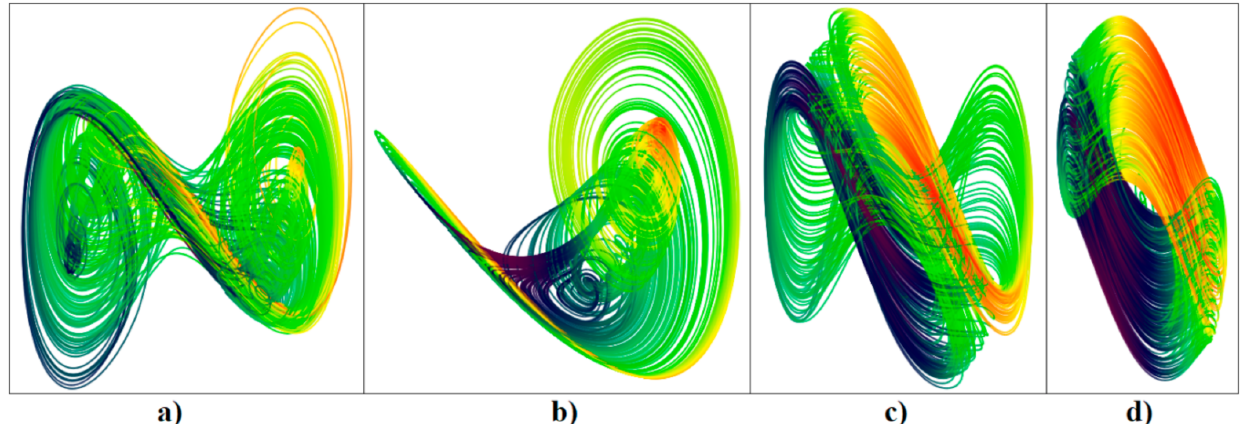
Figure 5. Strange attractors generated by Clapp oscillator, Case I, and visualized using v 1 – v 2 plane projection: ( a ) y 11 = 0.9 S , y 12 = 2.5 S , b = 5 A 3 V − 1 , ( b ) y 11 = 0.9 S , y 12 = 2.5 S , b = 3 A 3 V − 1 with set of initial conditions x 0 = ( 2 − 0.5 − 4 0 ) T , and ( c ) y 11 = 0.95 S , y 12 = 0.5 S , b = 3 A 3 V − 1 with initial conditions x 0 = ( 0 − 2 0 0 ) T , ( d ) y 11 = 1 S , y 12 = 0.1 S , b = 4.8 A 3 V − 1